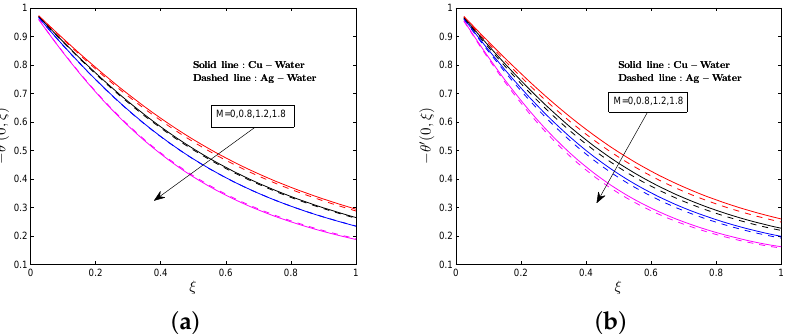
Figure 16. Heat transfer rate for various values of M . ( a ) vertical plate; ( b ) horizontal plate.